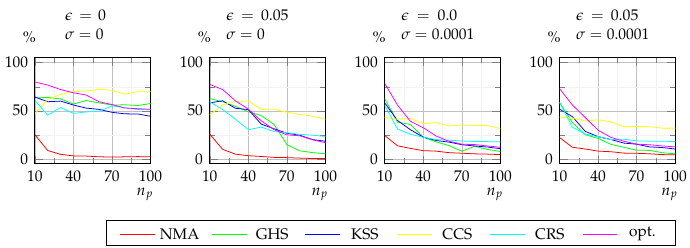
Figure 7. Share of expansion and contraction iterations for GH benchmark problems.